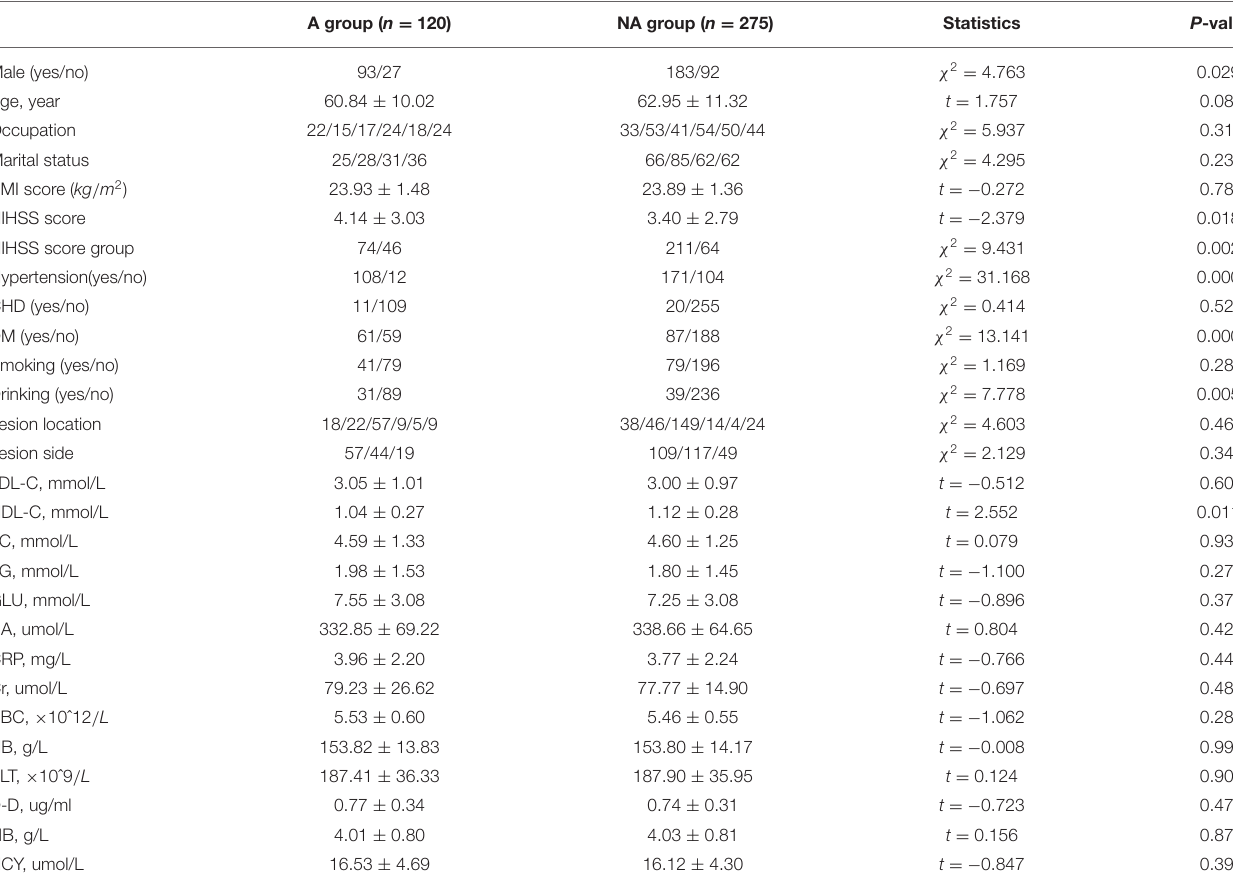
TABLE 3 | Significant characteristics between patients with and without post-stroke anxiety (PSA) by SAS scale ( n = 395). A group ( n = 120) NA group ( n = 275) Statistics P -value